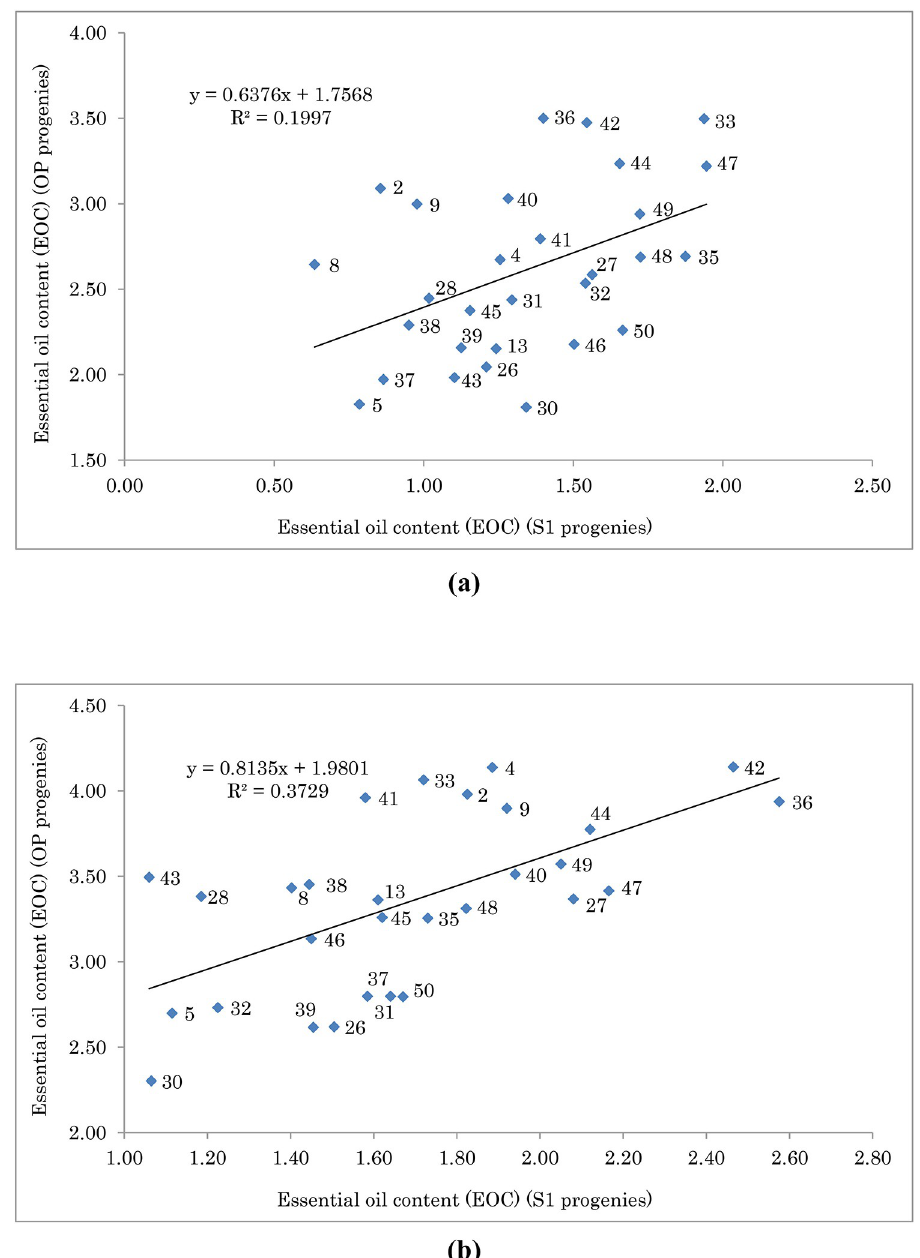
Fig 2. Essential oil content (EOC) of 29 selfed (S1) and open-pollinated (OP) populations of fennel under normal (a) and water deficit (b) conditions. The F-test indicated that the model is not significant for normal condition, and for water deficit condition is significant in 0.05 probability